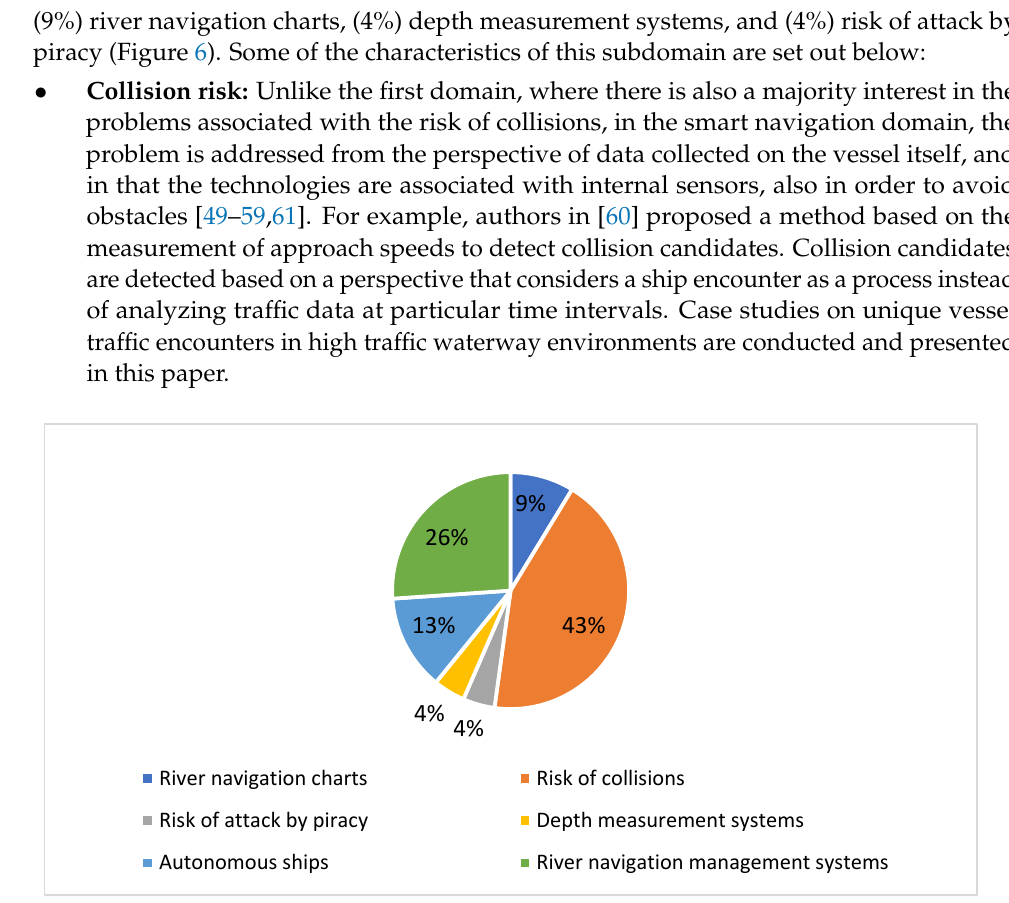
Figure 5. Subdomains in traffic monitoring.